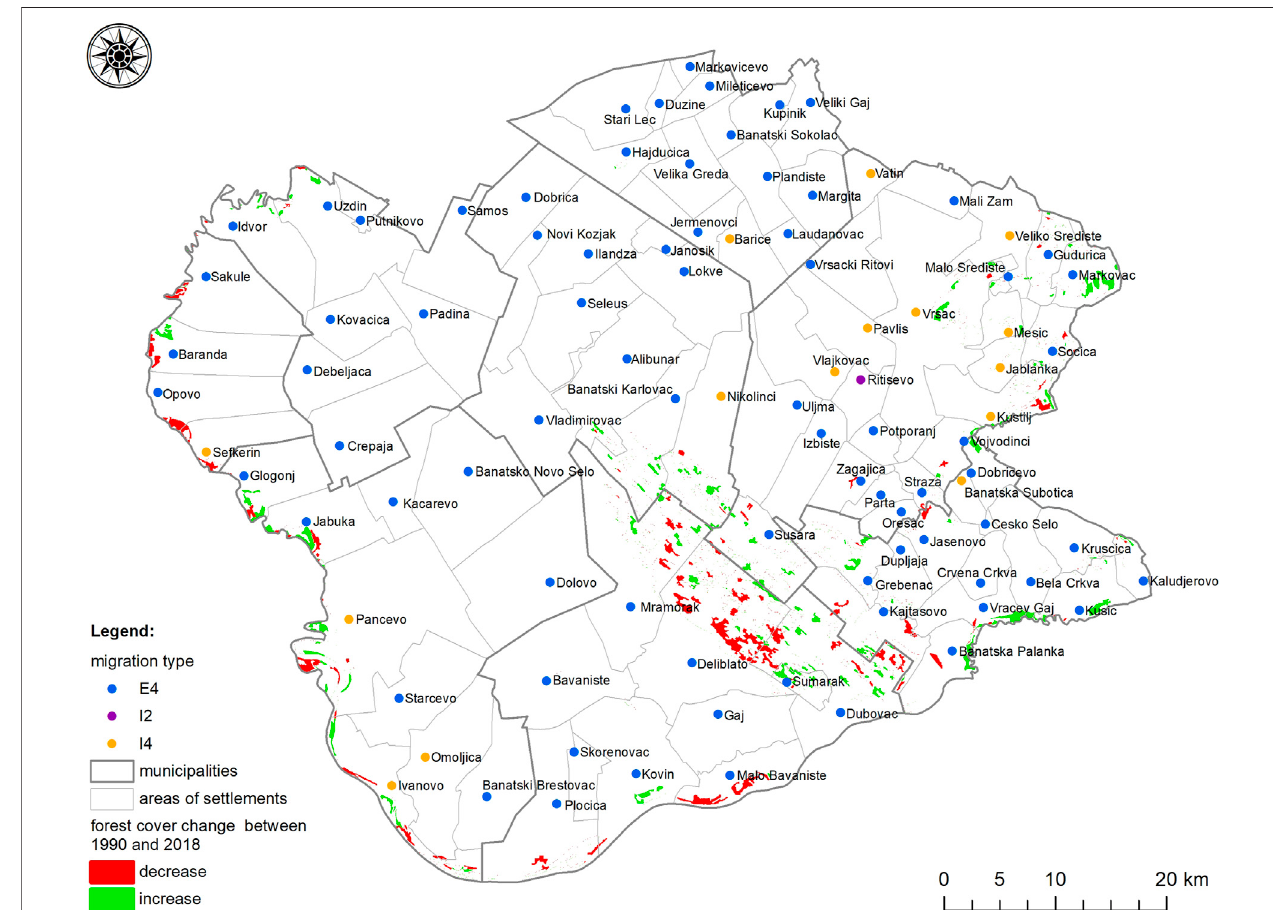
FIGURE 6 | The link between the type of movement of the population, settlements, and the forest cover.